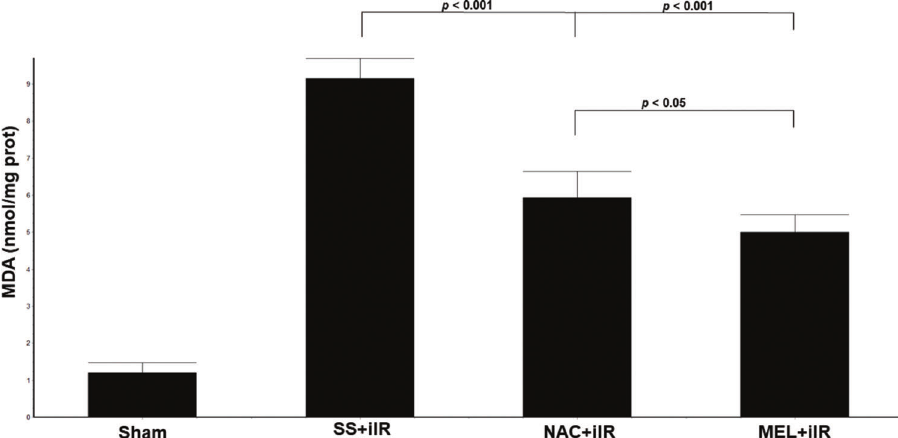
Figure 3 - Diagram showing the MDA levels of the animal groups. Note that levels were significantly reduced before NAC and melatonin administration, the reduction was more evident in the MEL group. Data are shown as the mean ± standard deviation of seven rats in each group. Sham: control; SS + iIR: control intestinal ischemia-reperfusion (iIR); NAC + iIR: NAC administration and iIR; MEL + iIR: Melatonin administration and